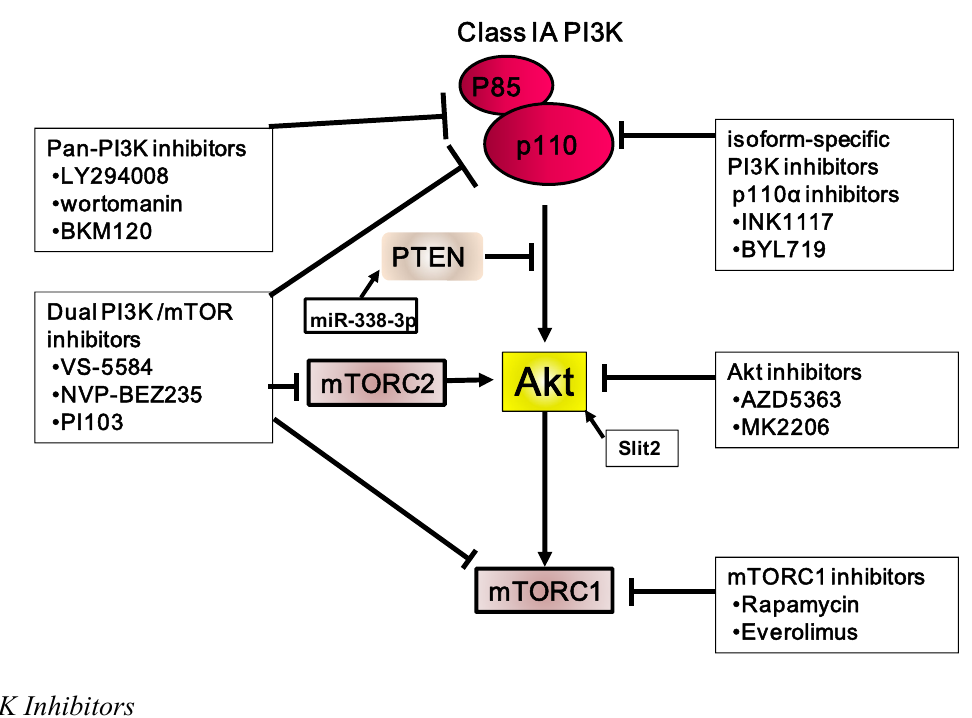
Figure 3. Summary of the PI3K/Akt/mTOR inhibitors used in gastric carcinoma, including those used in clinical trials. Stimulatory events are indicated by arrows and inhibitory events are indicated by lines ending in flat